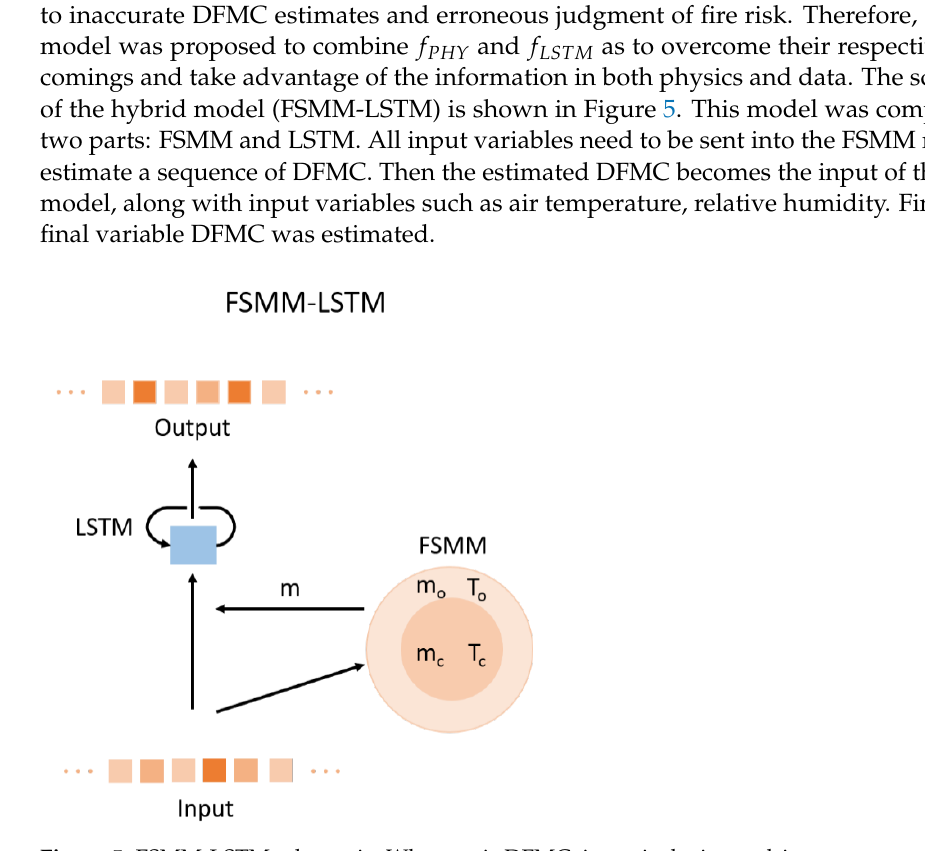
Figure 5. FSMM-LSTM schematic. Where m is DFMC, input is the input drivers. Since the input variables of the FSMM-LSTM model contain not only the input drivers used in the LSTM network but also the output of the FSMM model, we cannot use the optimal LSTM network parameters to optimize the FSMM-LSTM model. Therefore, we adjusted the hyperparameters by multiple debugging. The training hyperparameters for the FSMM-LSTM algorithm is shown in Table